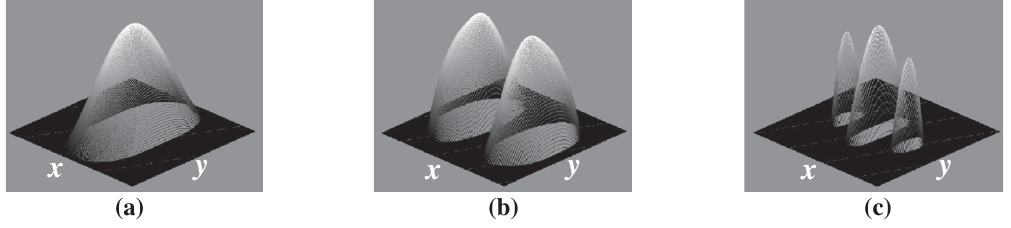
FIG. 2. Numerically calculated normalized photon number density distributions having x and z linearly polarized components, 2 = ℏ ω , for 1st 0 < ℏ ω < 7 . 6 keV (a), 2nd 7 . 6 < ℏ ω < 15 . 2 keV (b), and 3rd 15 . 2 < ℏ ω < 22 . 8 keV (c) harmonics in ∼ j E LW j 16 × 16 mrad square where a 0 . 6 and E 65 MeV. The direction of the laser ’ s polarization is along the x L ¼ 0 ¼